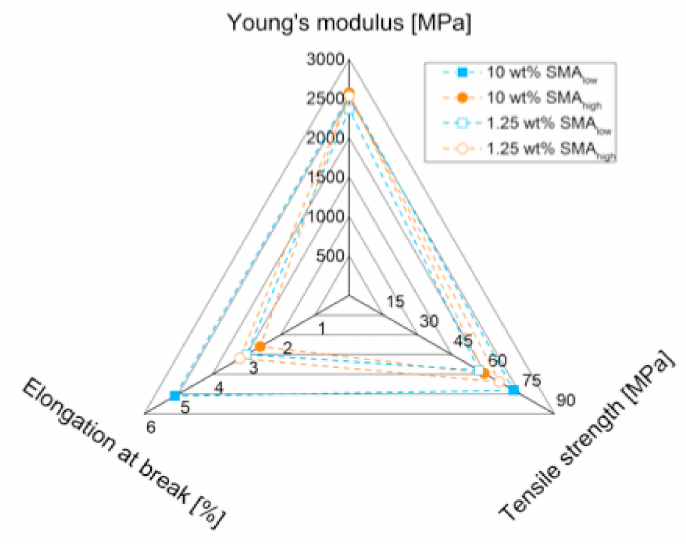
Figure 9. Summary of tensile properties for SMA (high and low) compatibilized PA66 / PPE blend